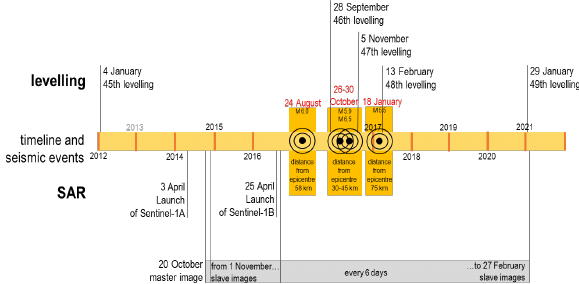
Figure 7. Determination of the “zero date” of the temporal